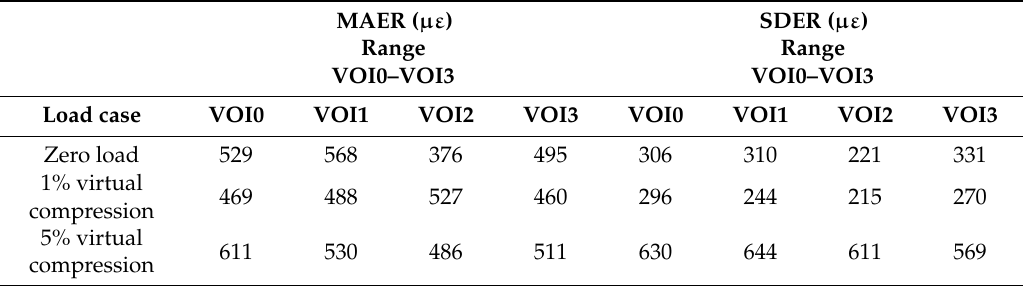
Resampling the images reduced slightly the errors for the zero-strain analyses in the whole femoral head (MAER from 599 to 258 µε , and SDER from 485 to 311 µε ). As expected, across all specimens, uncertainties decreased with increasing NS, following a logarithmic pattern [34]. At the resampled resolution of 78 µ m, a NS of 25 voxels (1.950 mm) yielded the best compromise between spatial resolution and accuracy. Across all 5 specimens, a NS of 25 voxels yielded a MAER between 399 and 729 µε and an SDER between 437 and 612 µε